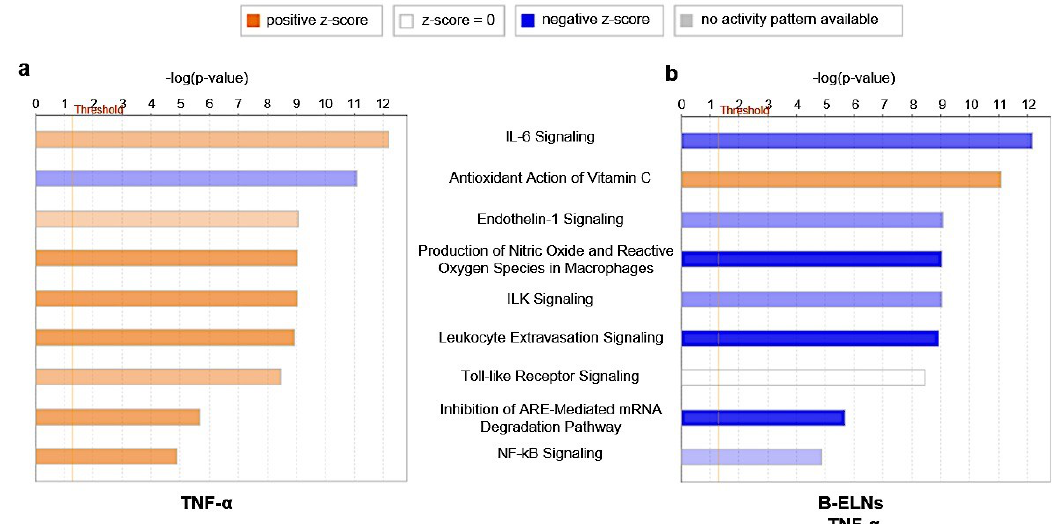
Figure 7. Enriched canonical pathways of 29 di ff erentially expressed (DE) genes in EA.hy926 cells exposed to TNF- α ( a ) and pretreated with B-ELNs before TNF- α exposure ( b ). The significance of canonical pathways was determined by Ingenuity Pathway Analysis (IPA)’s default threshold [–log( p -value)] > 1.3. p -value was calculated by Fisher’s exact test. Color gradients of histograms vary from red (activation) to blue (inhibition) according to the Z-scores calculated for each enriched function.